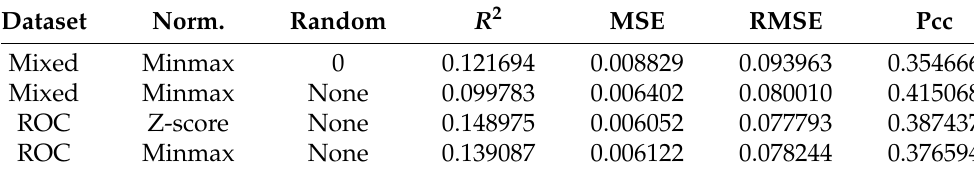
Table 5. Top 2 best metric performers in WNN regressor.